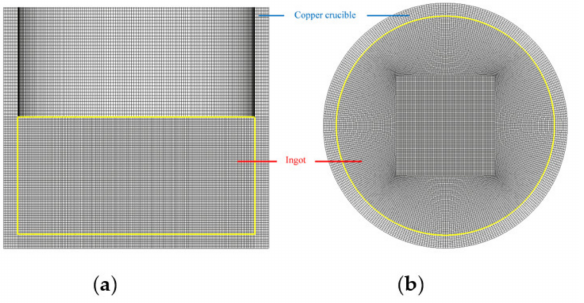
Figure 3. Schematic diagram of mesh used in simulation: ( a ) local longitudinal section; ( b ) top view.